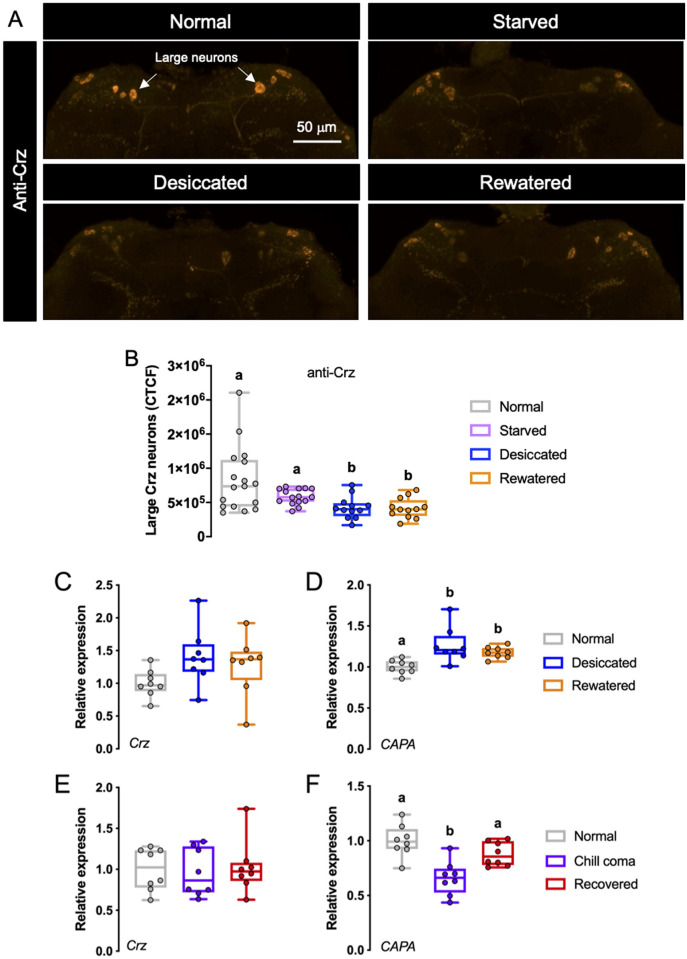
Crz peptide and transcript levels following nutritional and osmotic stresses.(A, B) Crz peptide levels in large neurosecretory cells (indicated by white arrows) are lower in desiccated and rewatered flies compared to flies raised under normal conditions (p < 0.01, assessed by One-way ANOVA). (C)
Crz transcript levels are unaltered in desiccated and rewatered flies. (D)
CAPA transcript levels are upregulated following desiccation and remain high after rewatering (p < 0.05, assessed by One-way ANOVA). (E)
Crz transcript levels are unaltered following chill-coma. (F)
CAPA transcript levels are downregulated following chill-coma and return to normal levels after recovery at room temperature (p < 0.05, assessed by One-way ANOVA).